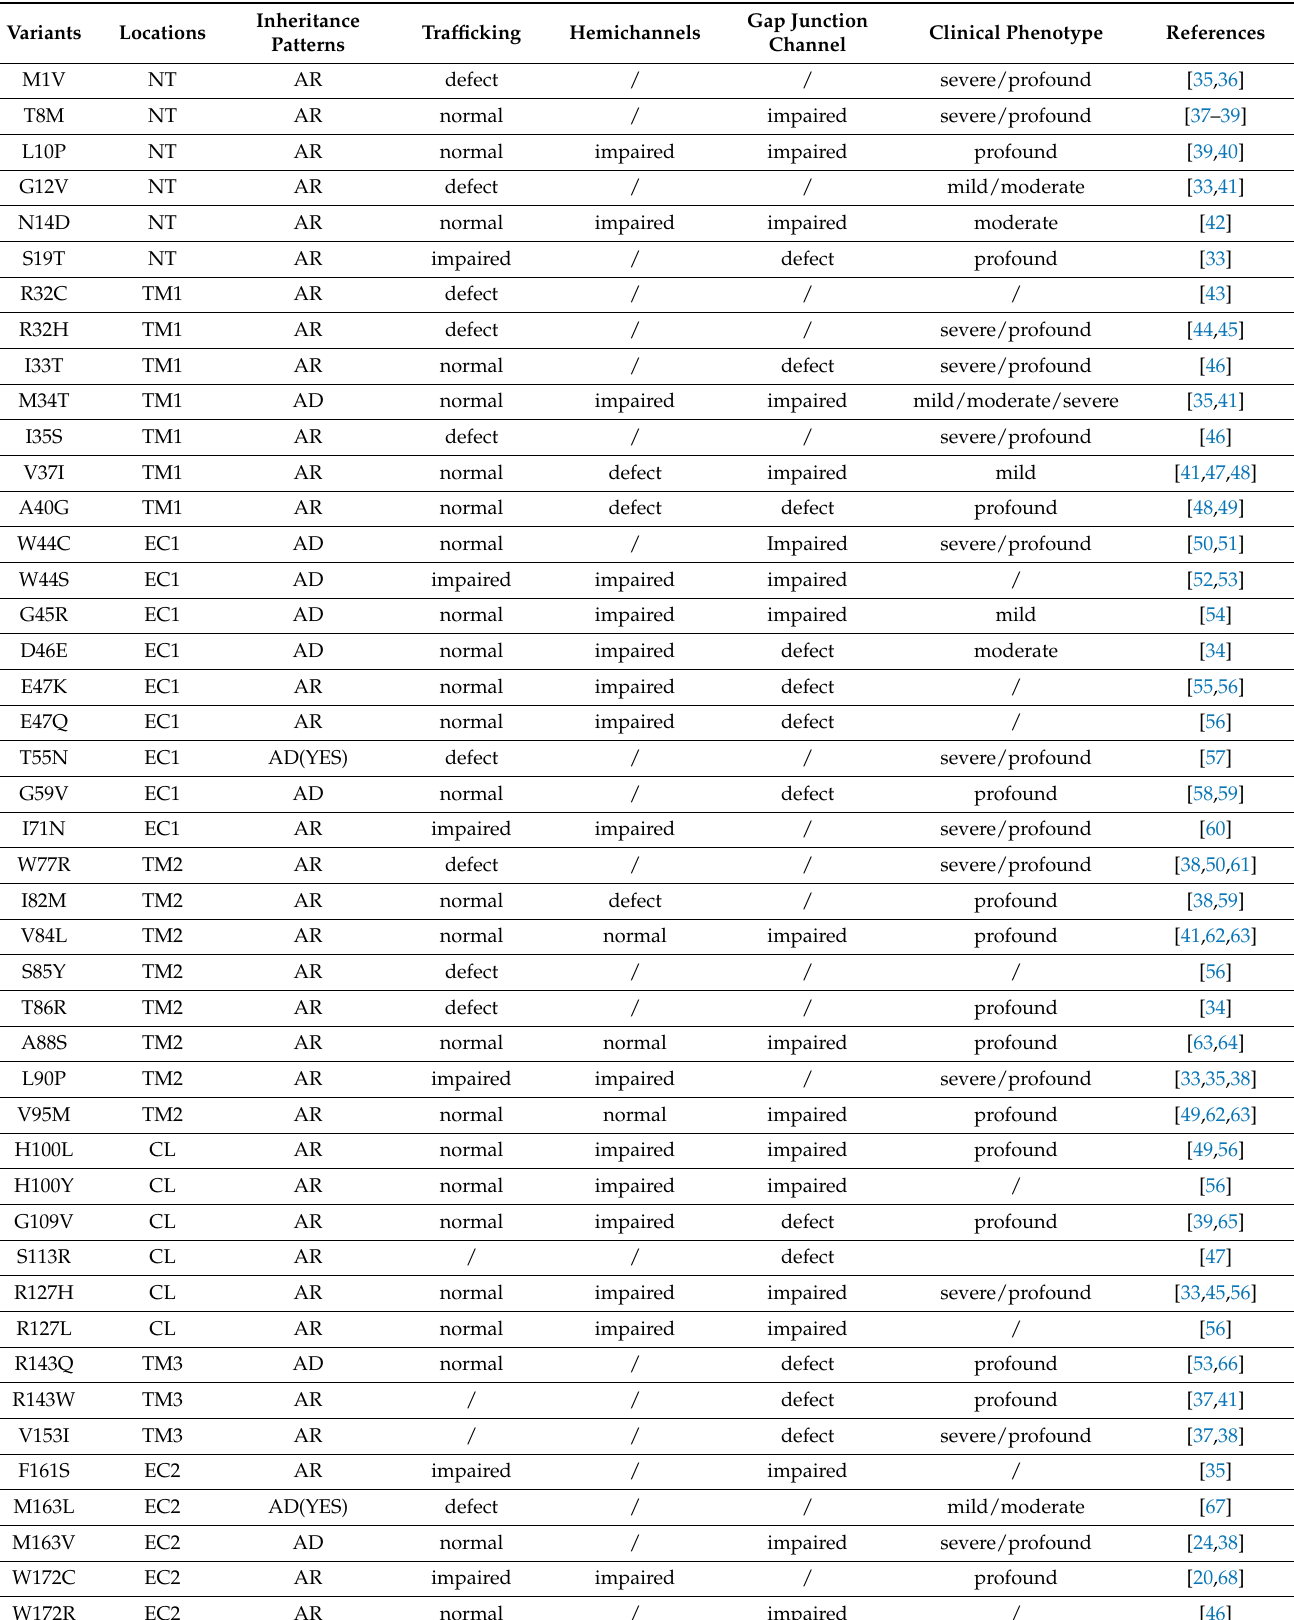
Table 1. Molecular mechanisms and phenotypes of nonsyndromic hearing loss